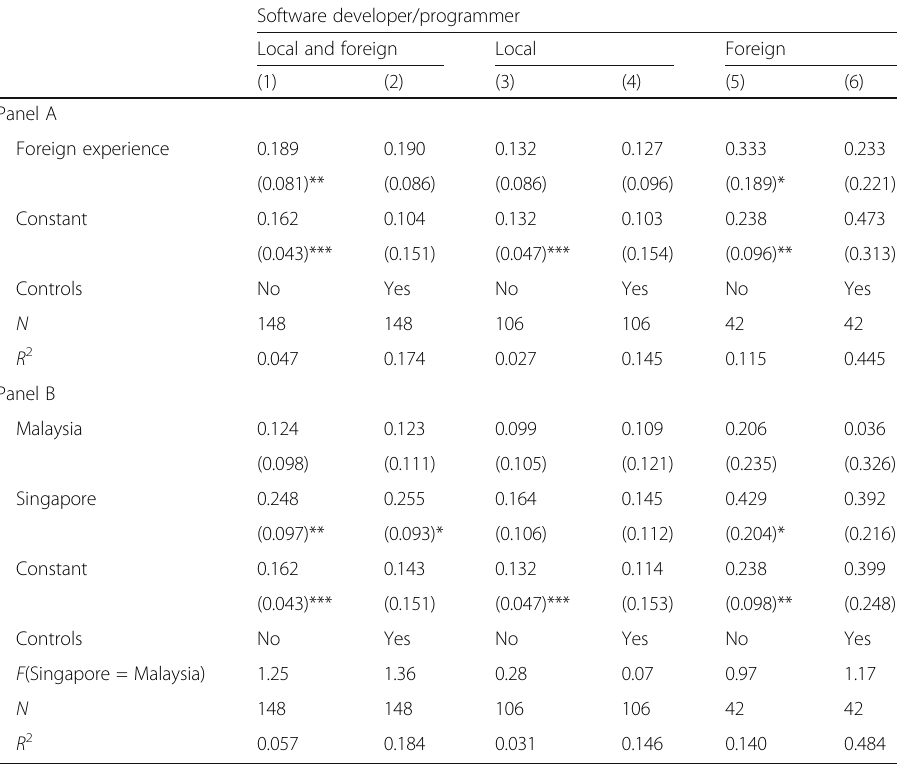
Table 4 Dependent variable: if a resume is the first to receive a callback for an interview (software